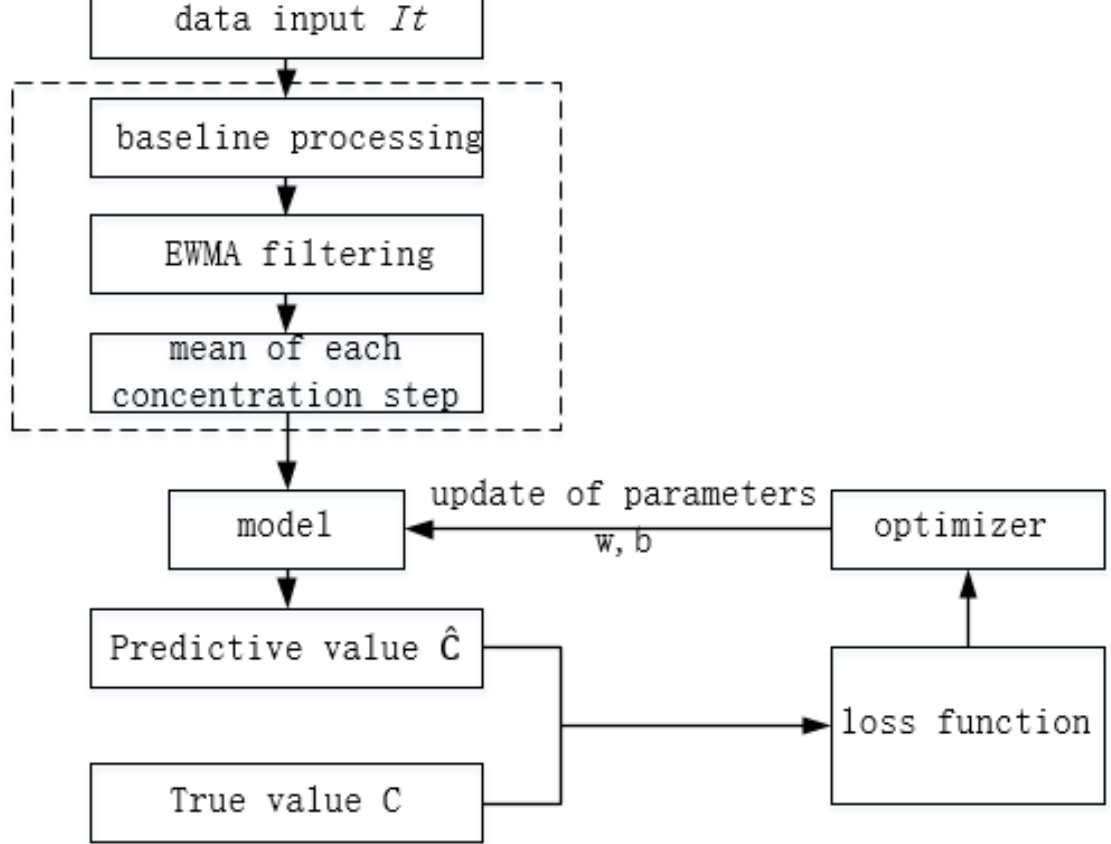
Figure 19. Preprocessing and model training process.